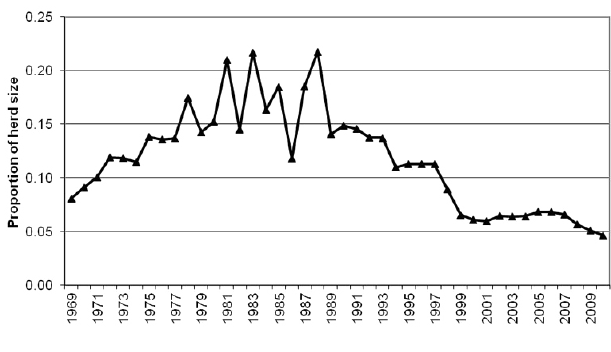
Fig. 7 . The harvest potential of the Taimyr wild reindeer herd 1969-2010. Harvest potential is the ratio of harvestable surplus (from Fig. 6) to total population size with a goal of zero population growth.